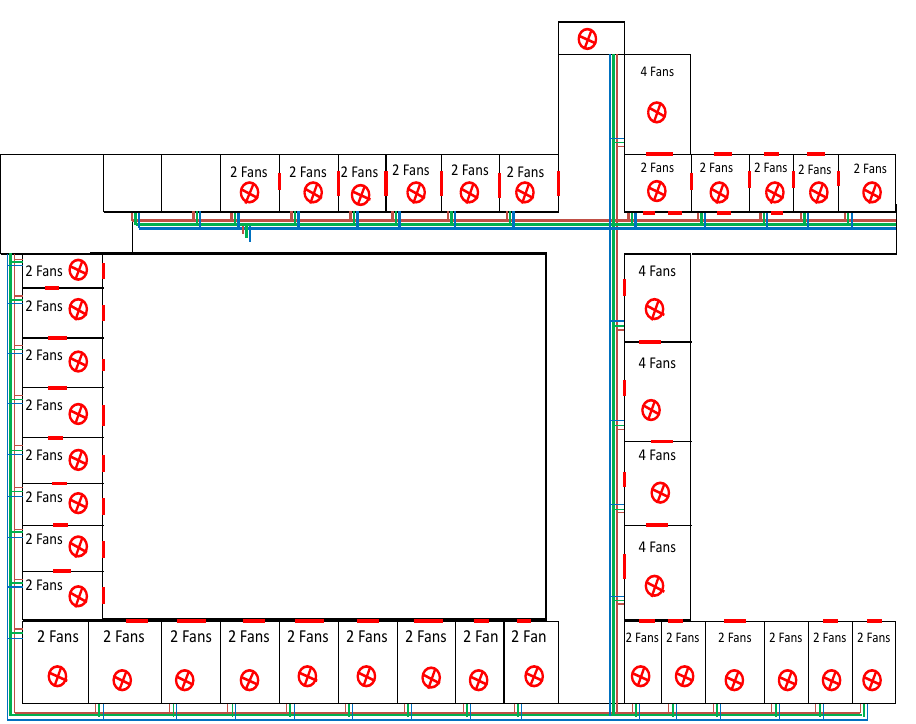
Figure 1. Sketch of the academic block.